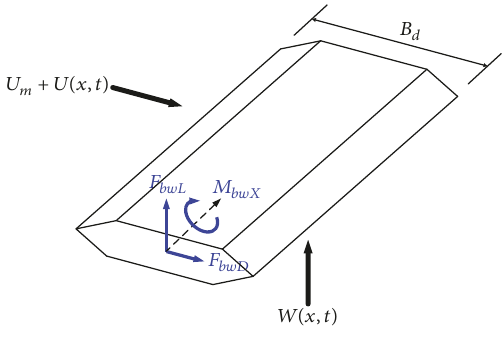
Figure 6: Wind loads on guideway structure.